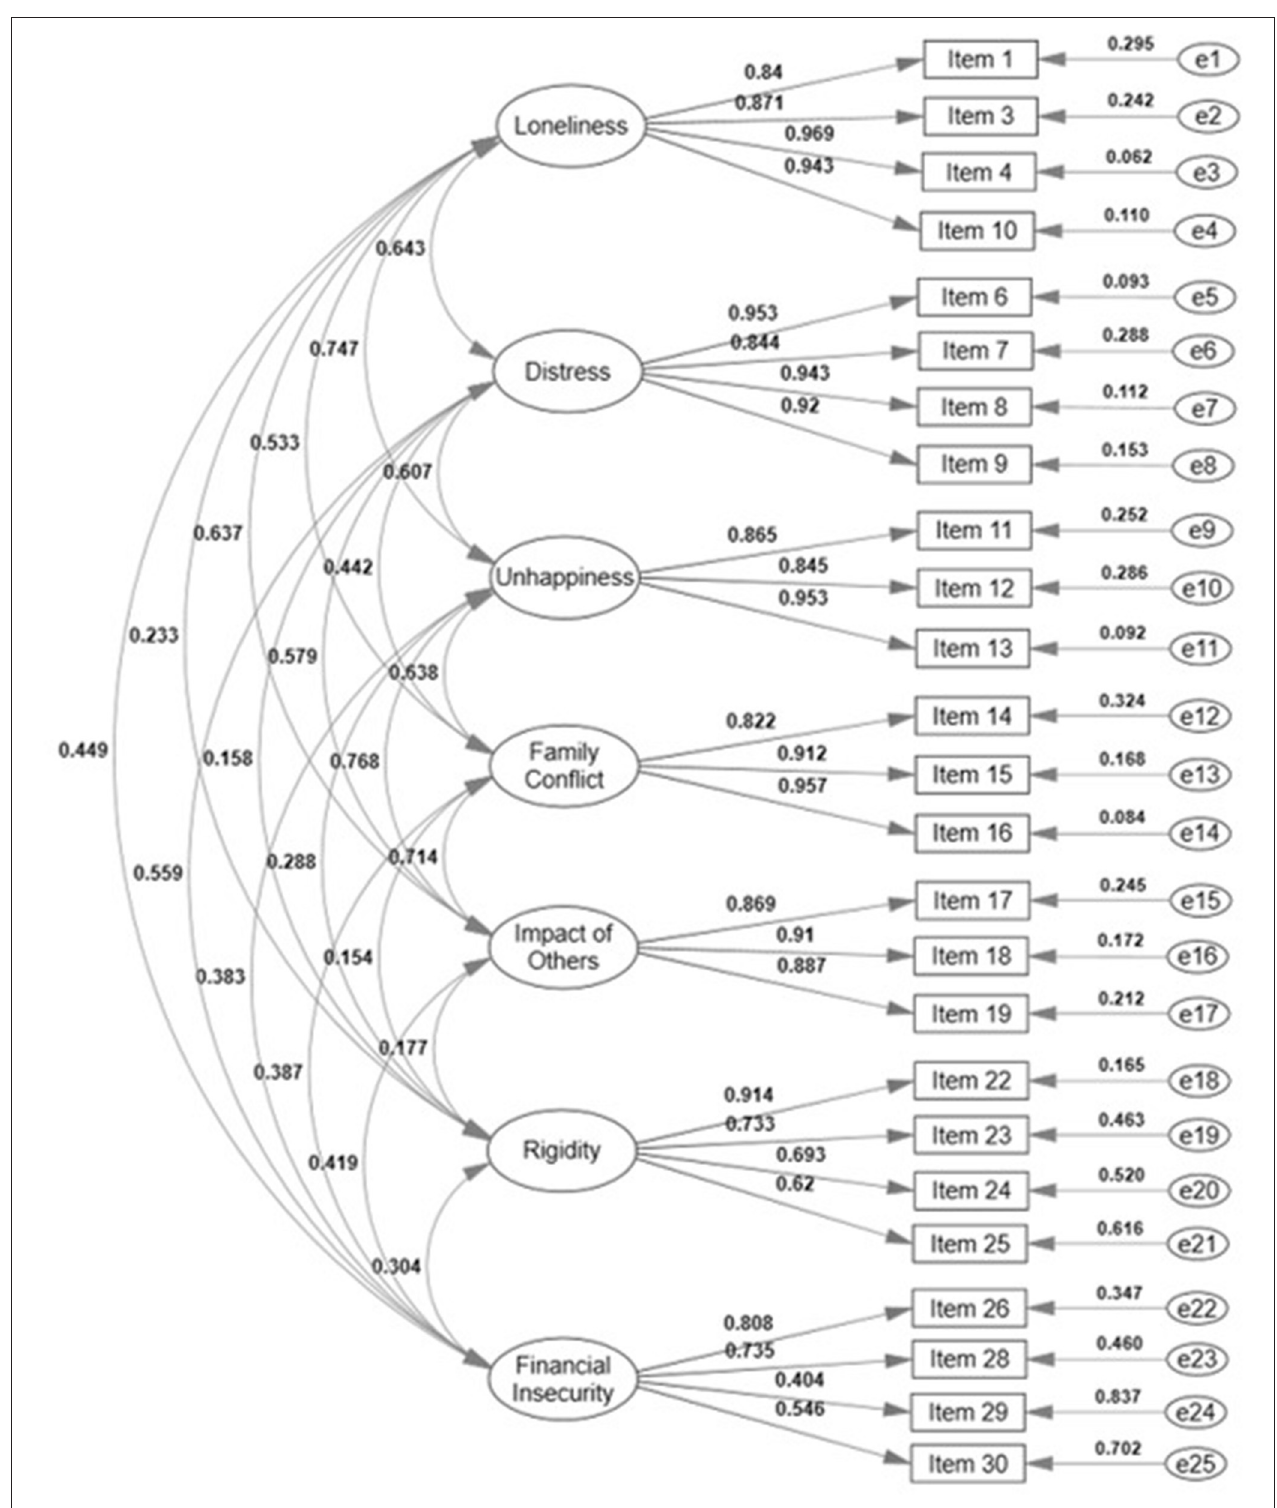
FIGURE 1 | Modified correlated 7-factor model of IBCAP-T. The estimates of the presented factor loadings, variances, and covariances are standardized.